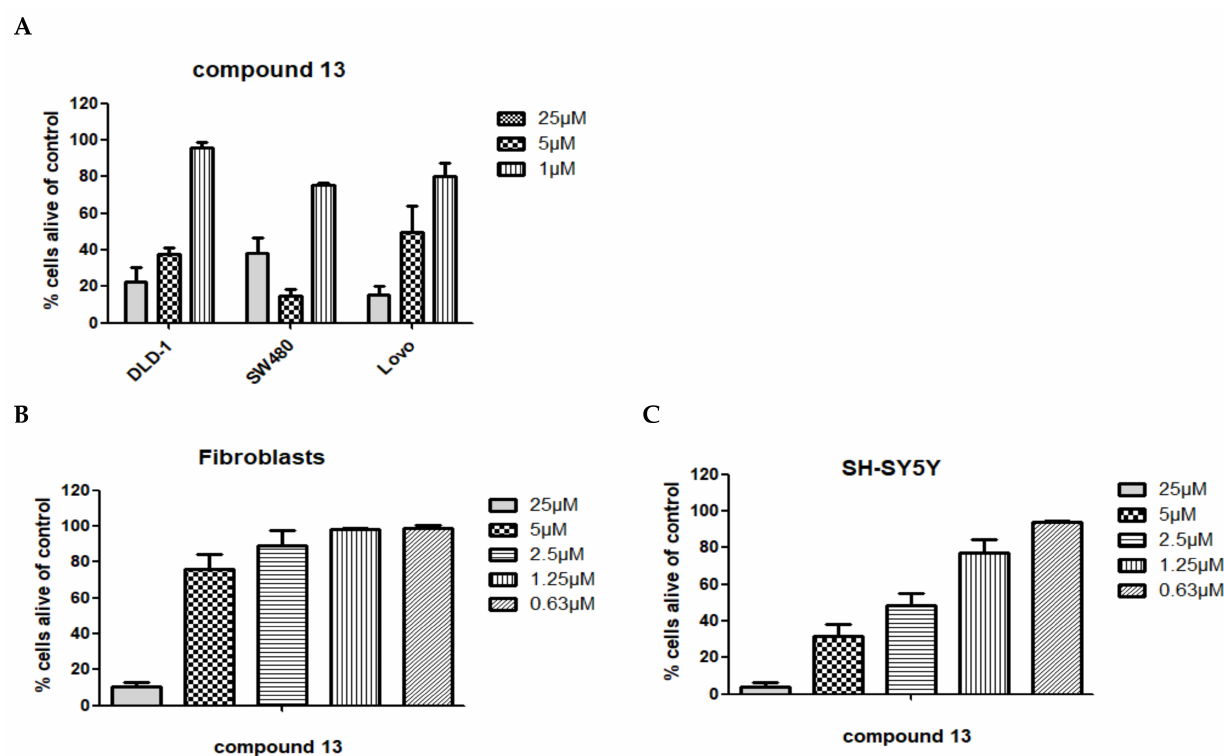
Figure 8. Influence of 13 at different concentrations on ( A ) different colon carcinoma cell lines, on ( B ) SH-SY5Y neuroblas- toma cell line, and on ( C ) primary human fibroblasts as non-cancerous control cells. Incubation time was 24 h followed by flow cytometric analysis (AnnV/PI staining). Percentage of cells alive was calculated compared to control (no treatment).